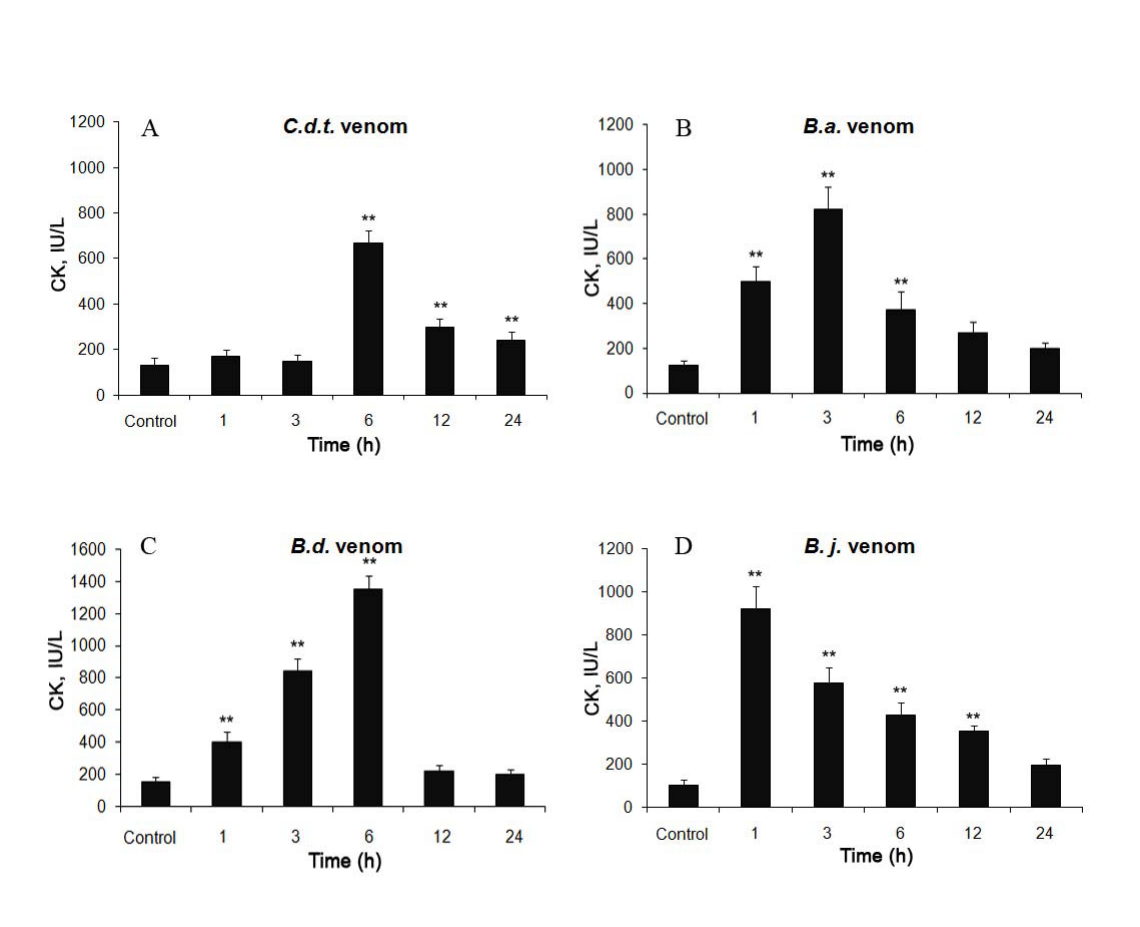
Figure 3 . Myotoxic activity of C.d.t. venom and bothropic venoms. ( A ) Effects of C.d.t . venom and ( B , C , D ) bothropic venoms on mouse skeletal muscle were measured by plasma CK levels (IU/L). Each point represent the mean + SD of five samples. ** p < 0.001; compared with the corresponding control